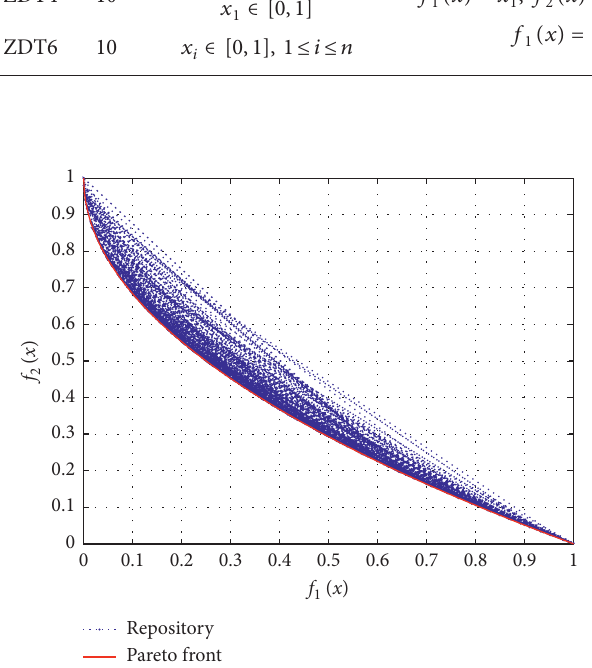
Figure 3: Pareto front produced by MOLFA for the ZDT1 test function.